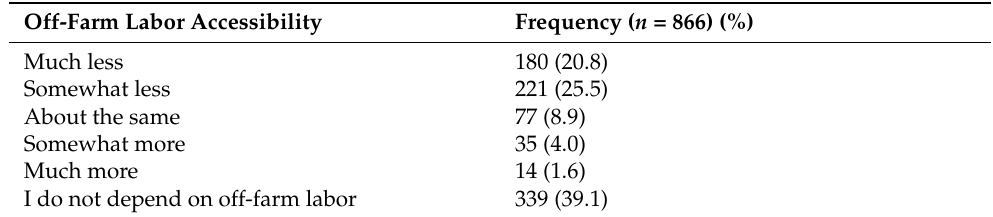
Table 8. If depending on off-farm labor, please indicate the level of access to labor throughout the agricultural